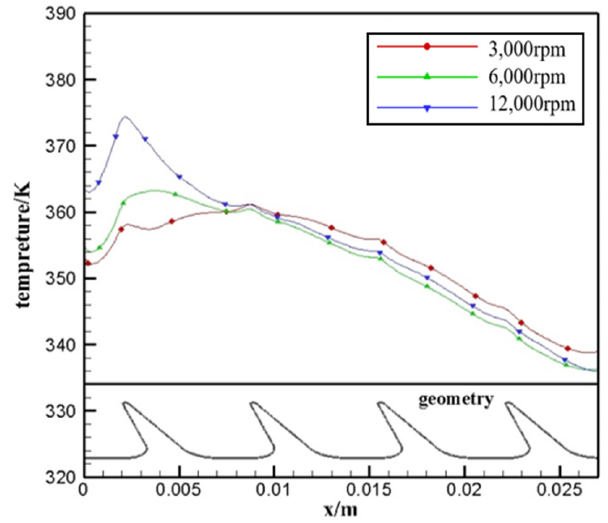
Figure 20. Nusselt number distribution of labyrinth bushing along the path.